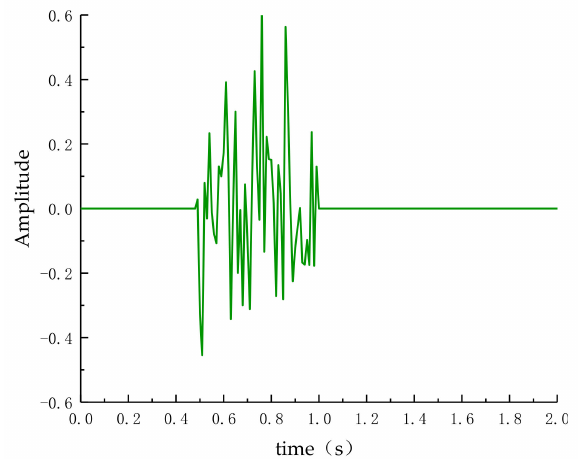
Figure 15. Gaussian white